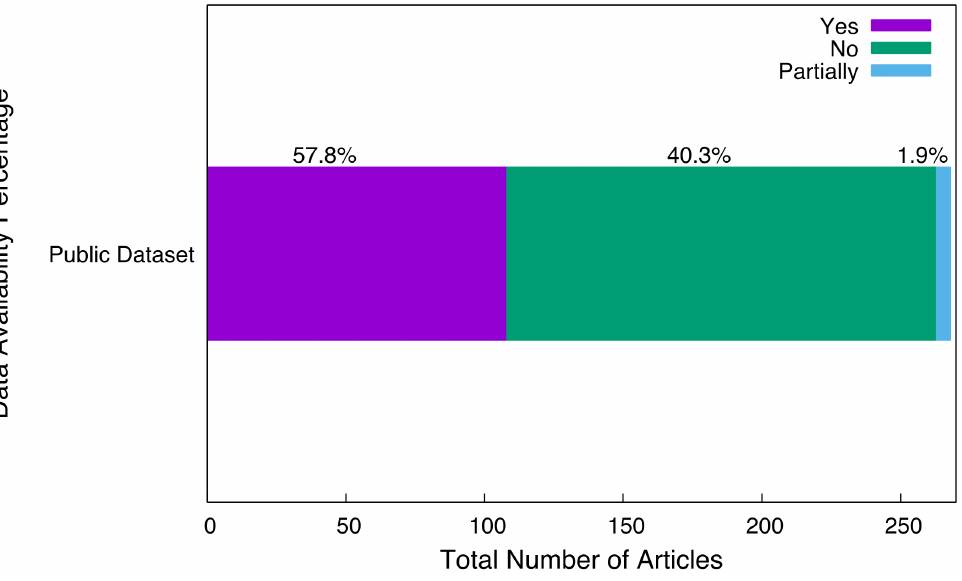
Figure 10. Dataset availability percentages provided by the